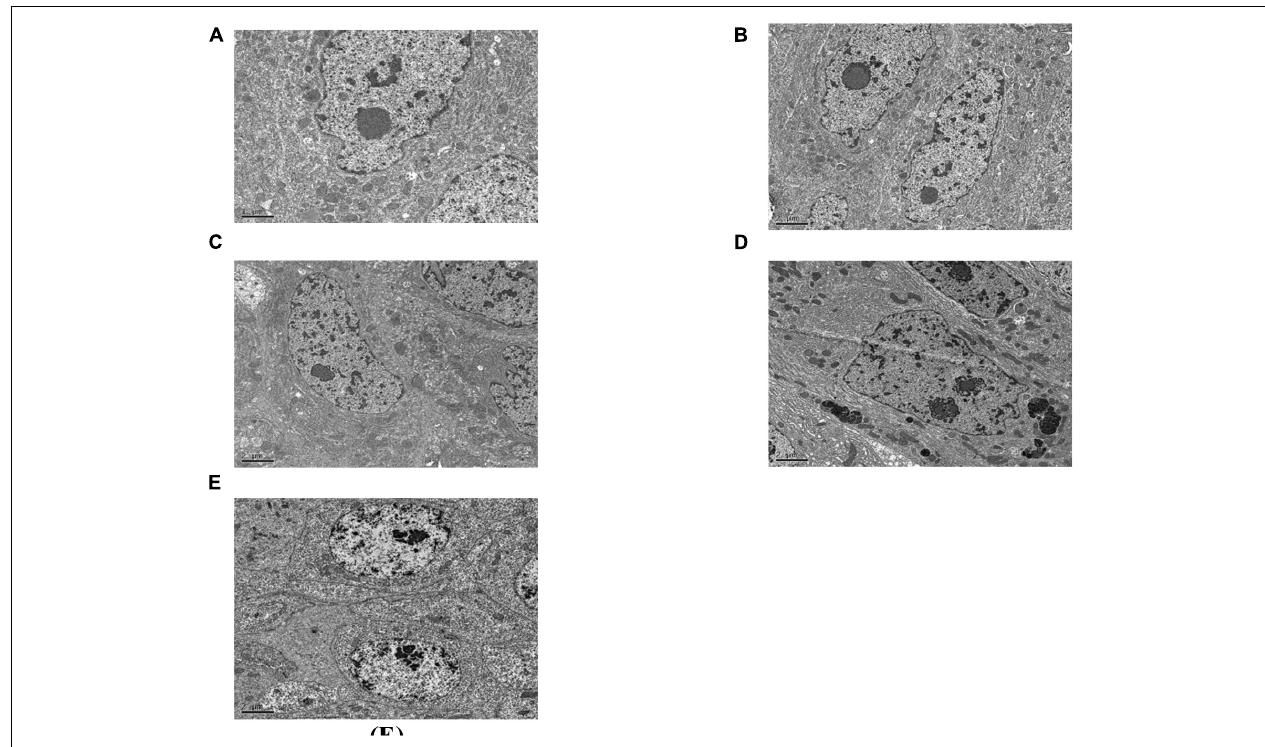
FIGURE 5 | Pathological effects of the Sip1Ab and Cry8Ca on midgut space of larvae of Colaphellus bowringi (A) Control group fed PBS for 3 days, (B) Cry8Ca treatment for 3 days, and (C–E) : 1, 2, and 3 days after treatment with Sip1Ab,